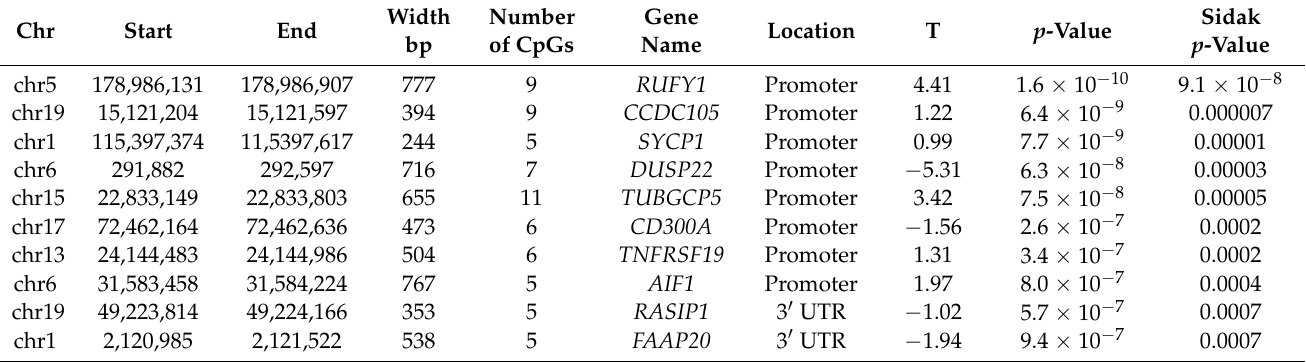
Table 2. Top 10 of differentially methylated regions (DMRs) in child PBMCs associated with IgE sensitization to airborne allergens at 5